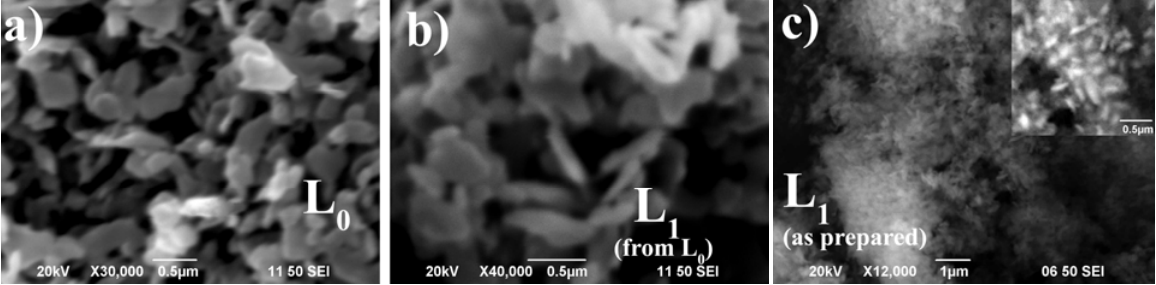
Figure 7. SEM micrographs of: ( a ) as prepared L heating and ( c ) the as prepared L selected